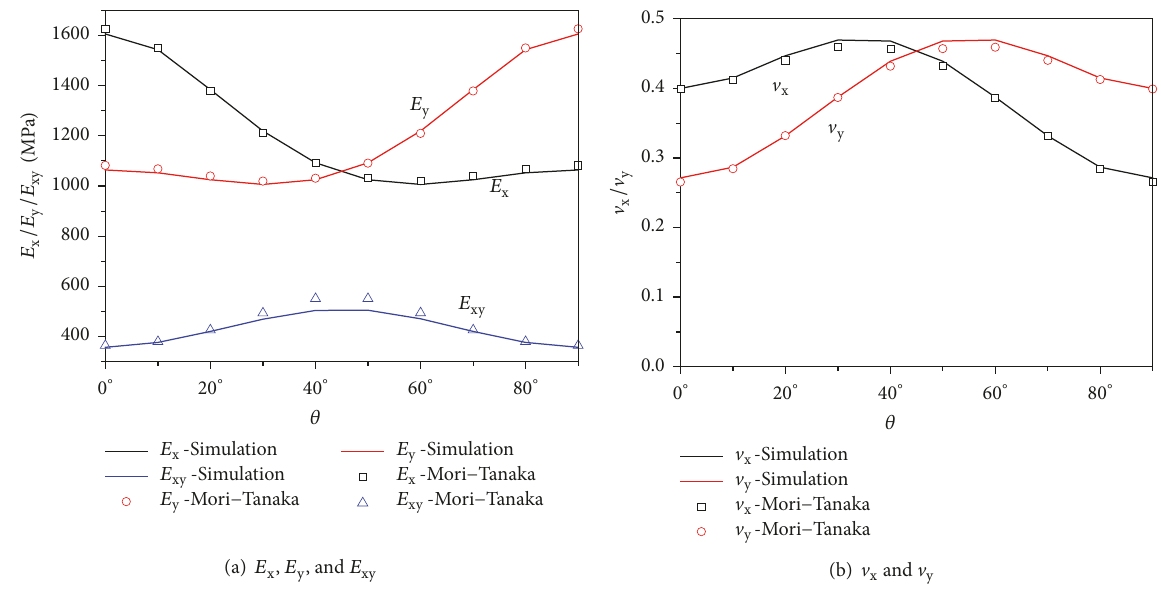
Figure 6: Comparison between the numerical and Mori–Tanaka model results for different elastic constants of a composite with 𝑙 f =1 mm and V f =0.01.